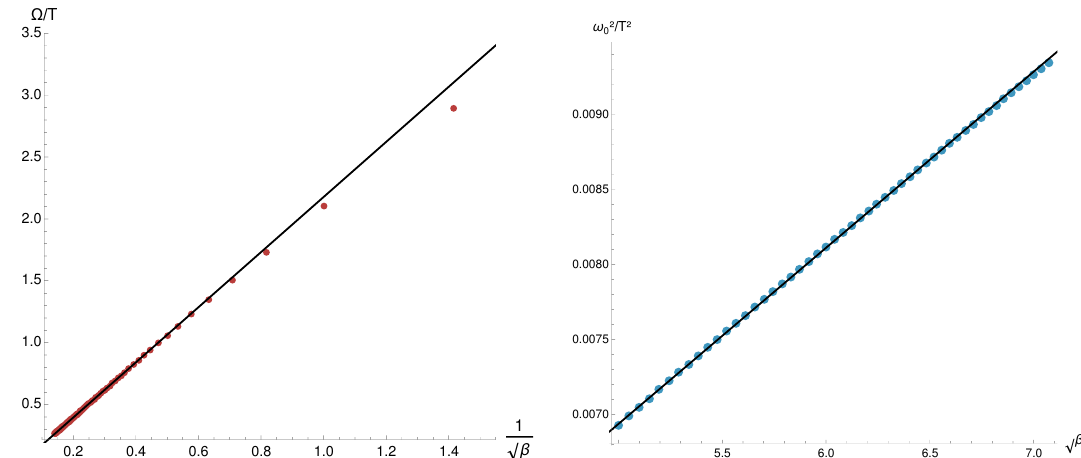
=T 2 for (cid:12)xed m=T = 0 : 03. 0